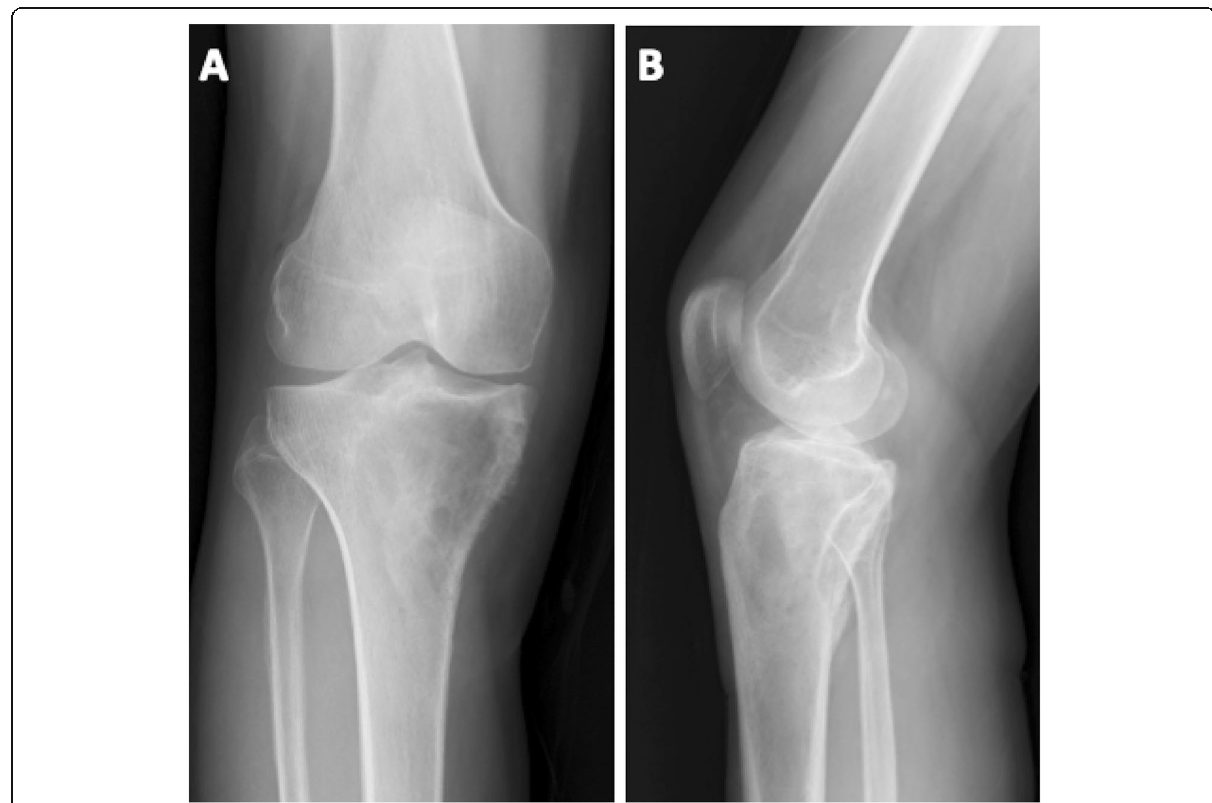
Fig. 1 a Anteroposterior and b lateral radiographs of the right knee in a 39 year-old male showing an eccentric lytic lesion in the proximal tibia with associated periosteal